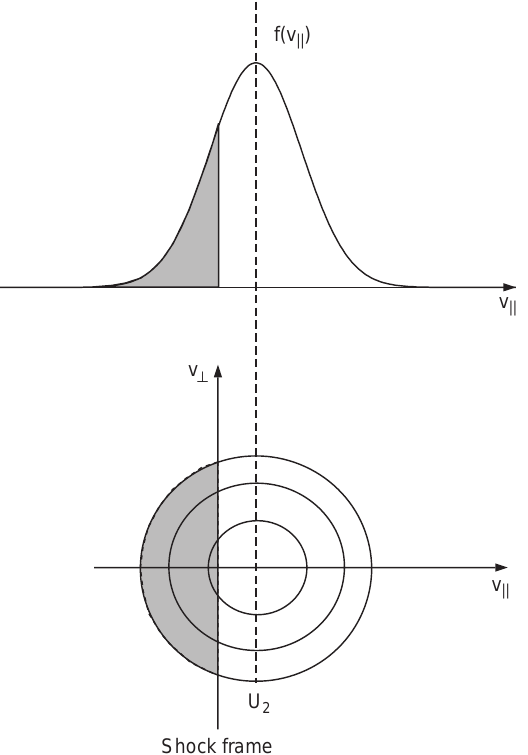
Fig. 13. Schematic showing the downstream reduced distribution function f (cid:133) v (cid:134) in the shock frame centered around the downstream jj bulk speed U 2 . The lower part shows iso-intensity contours of f . Ions in the shaded part have an upstream directed velocity and contribute